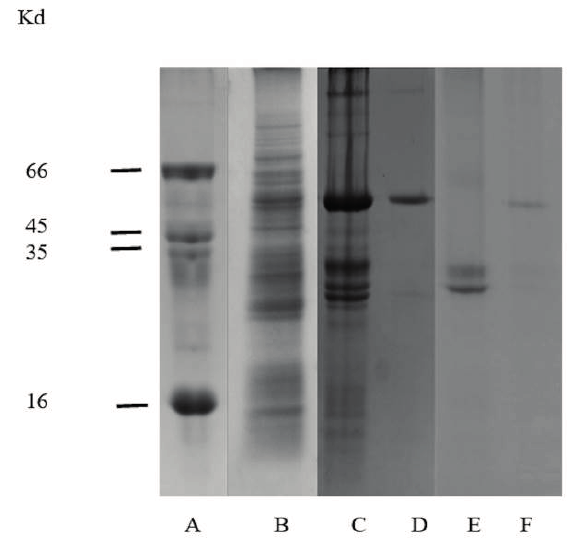
Figure 3. SDS-PAGEs from the purification process of S. edule . Molecular weight (Sigma-Aldrich, St. Louis, MO, USA) was used on Lane A : bovine serum albumin (66 kDa), ovalbumin (45 kDa), pepsin (35 kDa), and tripsin inhibitor (16 kDa); Lane B : Protein precipitation of crude extract; Lane C : Eluted fraction I (pH 6.7) from CMC column; Lane D : Eluted fraction two (pH 6.8) from CMC column; Lane E : Fractions I-III from size exclusion chromatography; Lane F : Fraction IV Sephacryl S-200HR chromatography (Sigma-Aldrich) purified protein with glucosidase